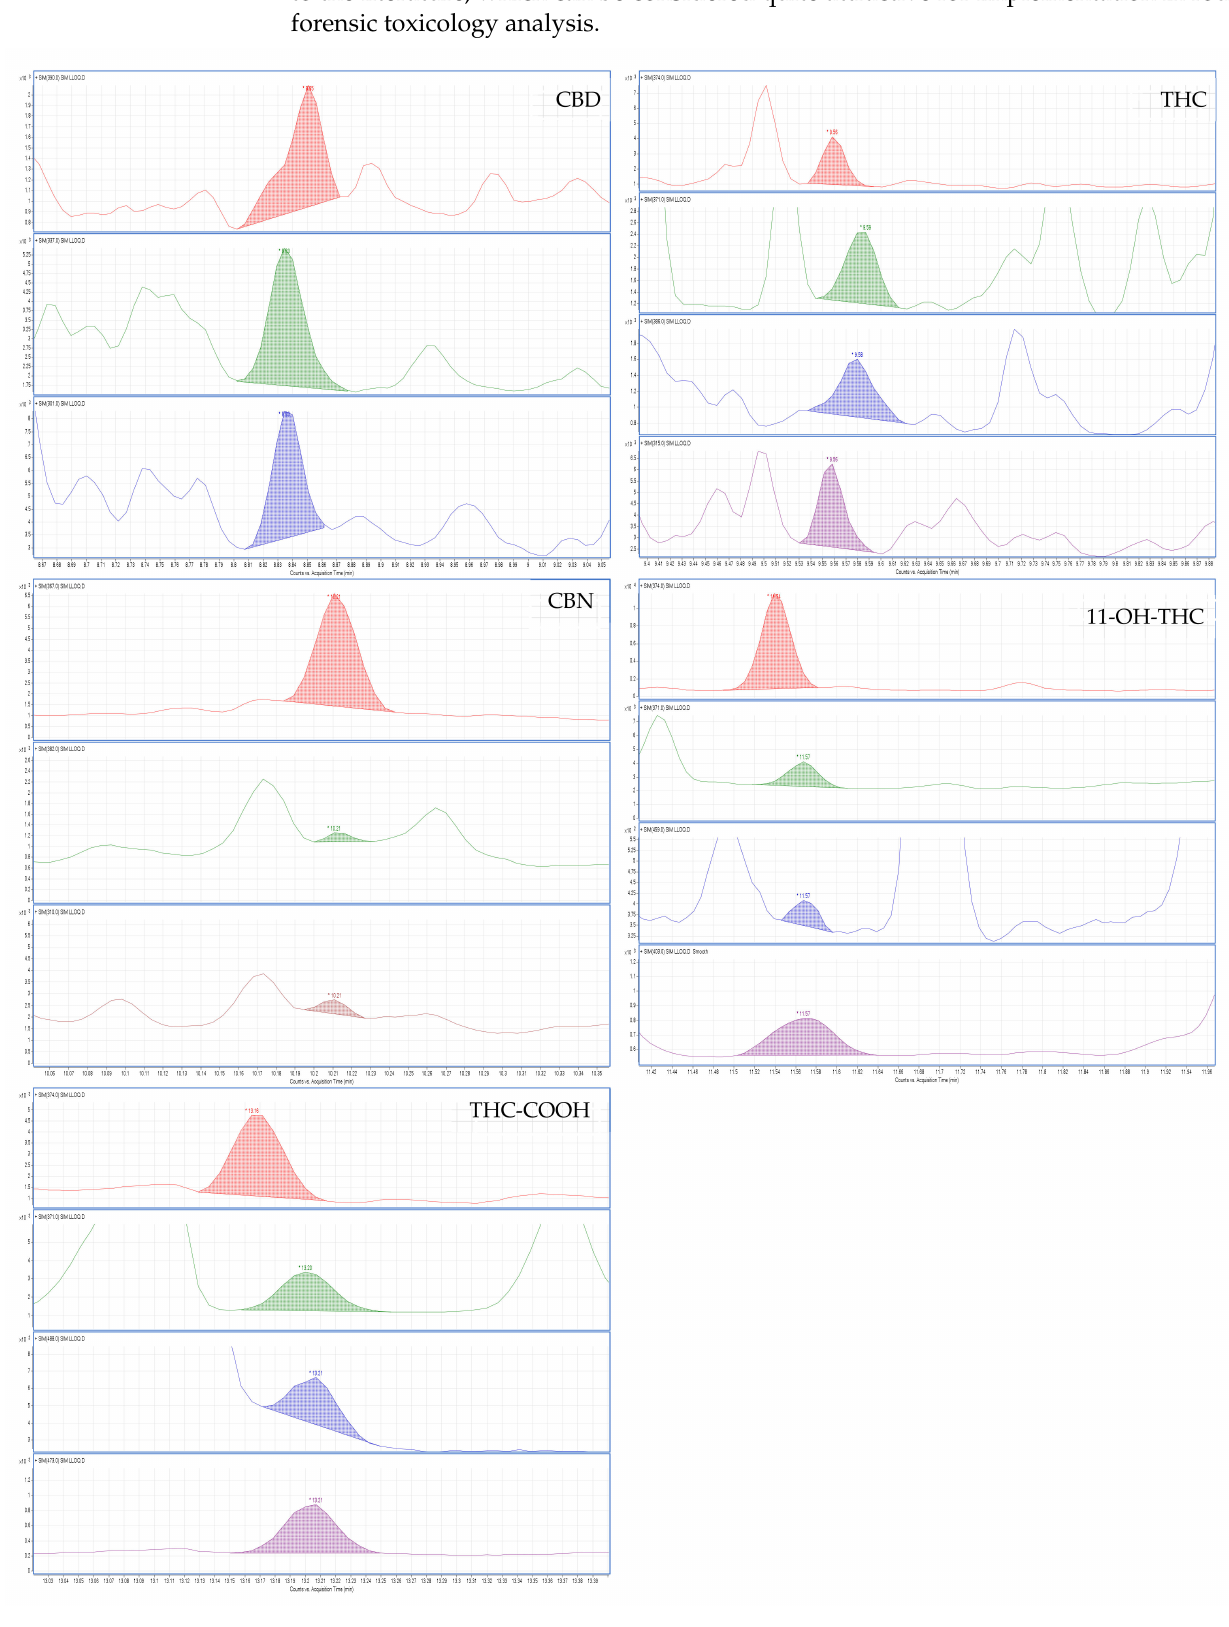
Figure 4. Ion chromatogram of a spiked sample at the LLOQ (1 ng/mL for CBD and THC, 5 ng/mL for CBN and 11-OH-THC, and 10 ng/mL for